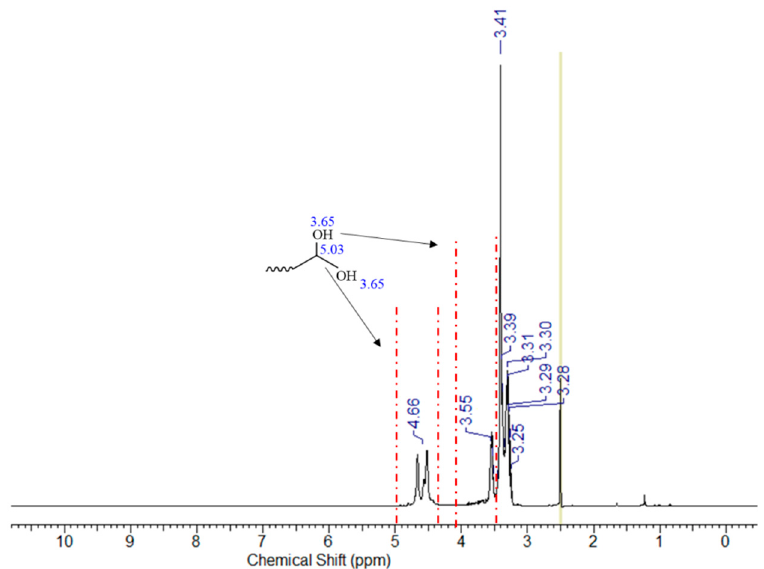
Figure 8. 1 H NMR spectrum of PGL 5/FC—fraction of PGL5/17/T12C16 with two –OH. (400 MHz, DMSO-d 6 ).